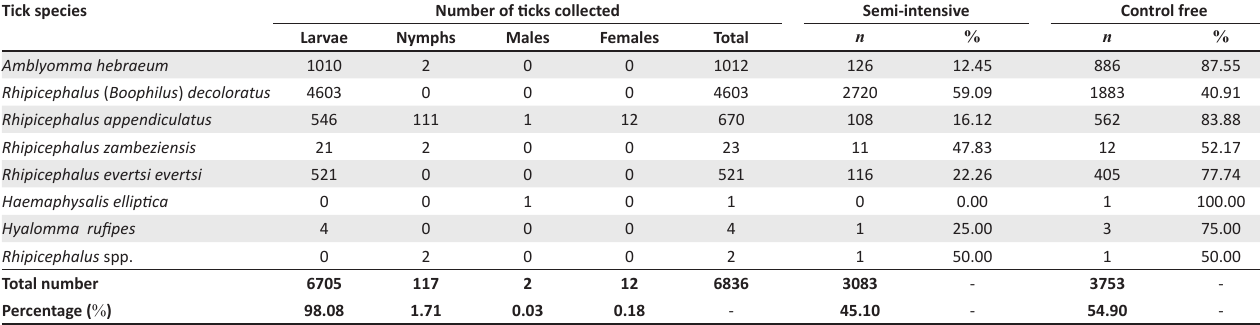
TABLE 1: Ticks collected on the farm ‘Hoopdal’ KQ96 from September 2003 to August 2008. Tick